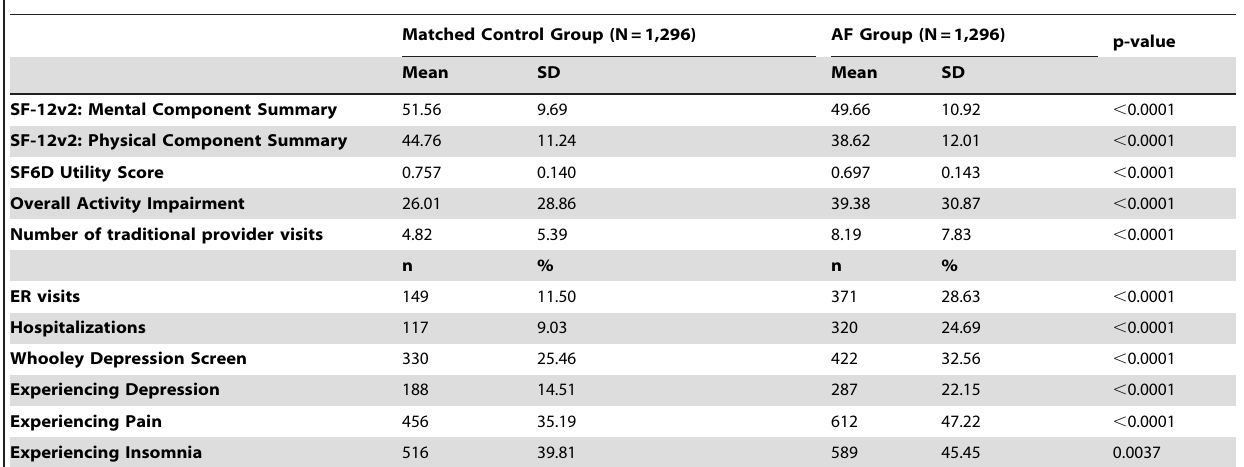
Table 2. Unadjusted health outcomes in patients with AF and matched controls.